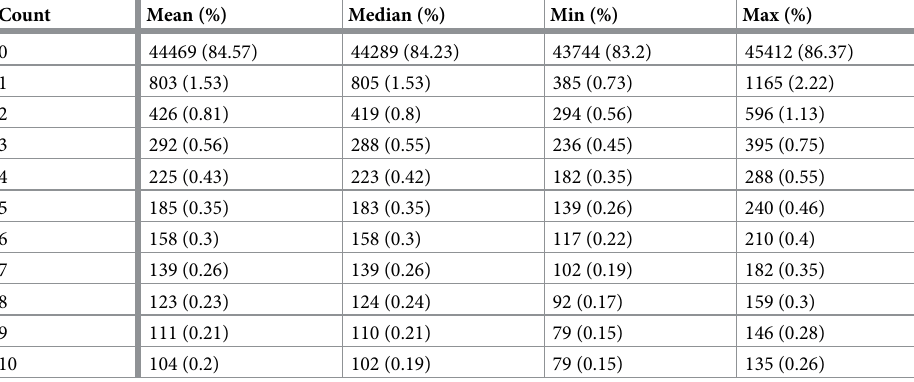
Table 1. Frequency distribution of small counts for the LCL RNA-seq